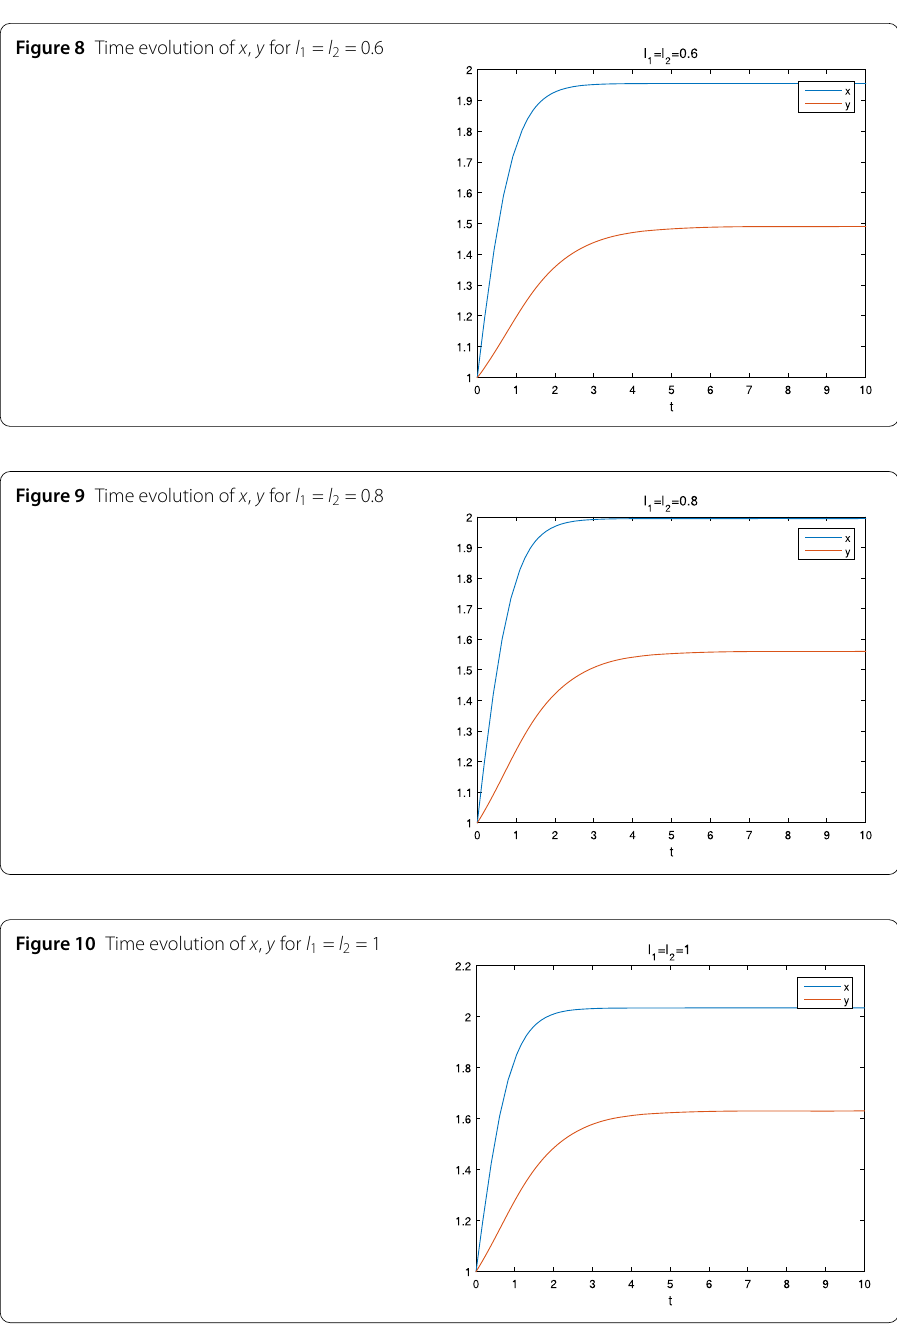
Figure 8 Time evolution of x , y for l 1 = l 2 = 0.6